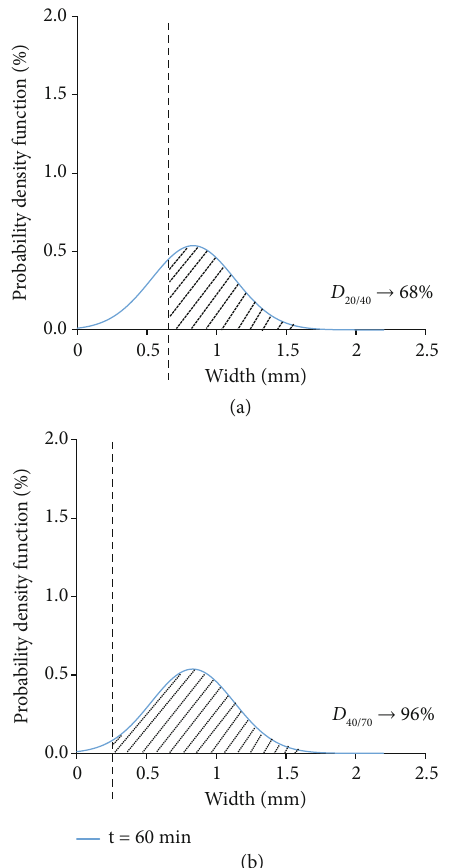
Figure 17: Probability density function of the fracture width at t = 60 (min). The probability of the proppant to fi t inside the created fracture width is represented by the hashed area. The success rate of 68% for D 20/40 and 96% for D 40/70